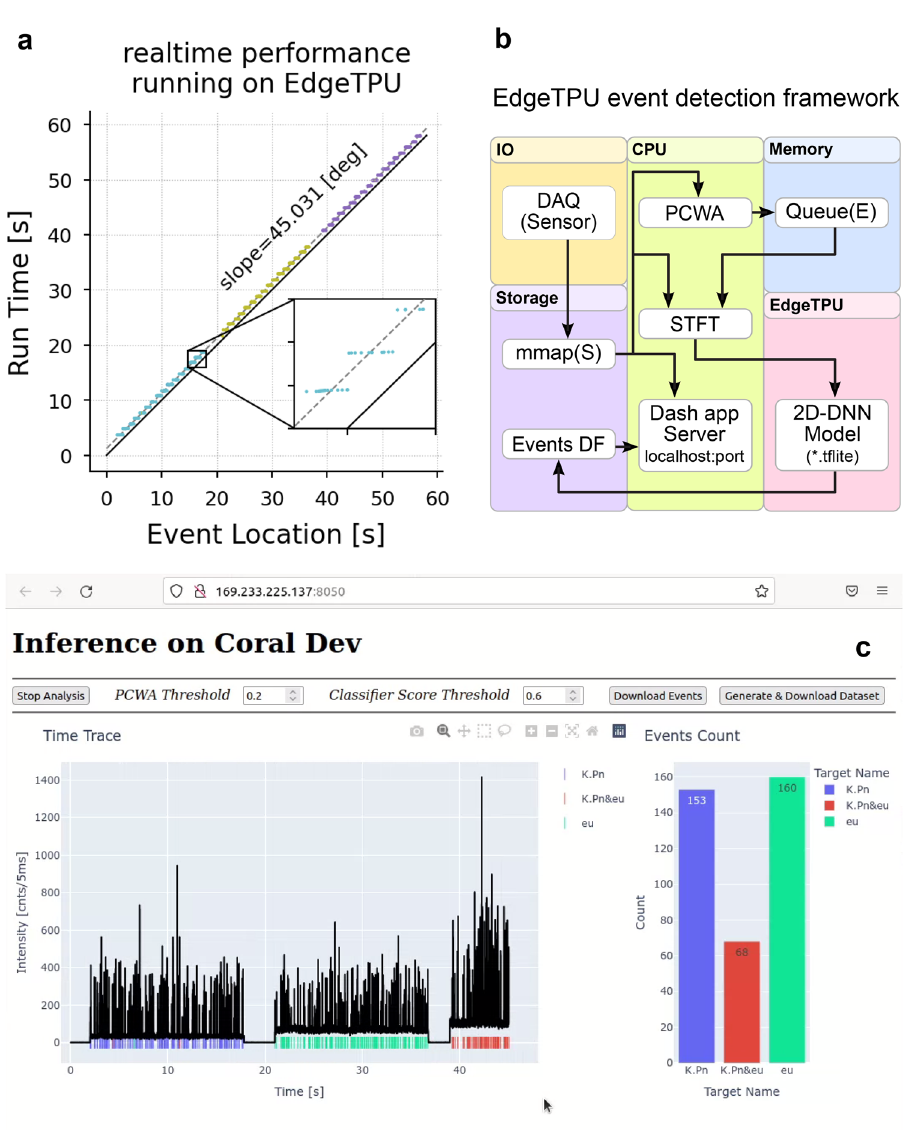
Figure 4. Detection on edge. ( a ) Real-time performance of the model running on Edge-TPU (Coral Dev board). By utilizing a pipelined architecture shown in ( b ), there is only a delay for the first batch, and the rest is processed without any additional delay. The 45-degree slope indicates the real-time calculation of results. The input data is processed in chunks cached in a queue; this is visible in the inset plot where multiple events are revealed at the same time. ( b ) A simplified block diagram showing the essential blocks of the pipelined data processing framework. Some blocks, i.e., DAQ, PCWA, and STFT, run in parallel using Python’s multiprocessing package. Out of 489 detected events on the Edge-TPU, 485 events are confirmed by manual inspection. Of 488 ground-truth events, 485 are correctly located, and 484 are classified, corresponding to 99% accuracy. ( c ) Developed Dash app running on Coral Dev board. Data from the sensor with identified events are visualized in different ways. The dashboard provides good insight into the analyzed sample in real-time.